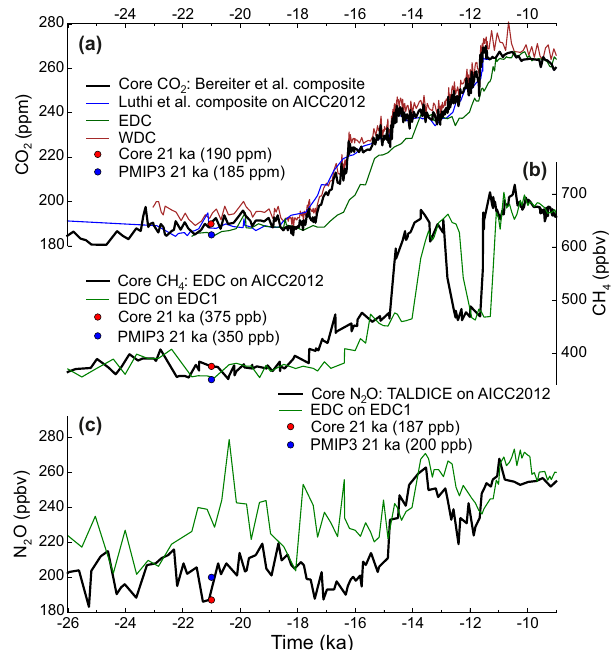
Figure 3. Atmospheric trace gases through the last deglaciation from Antarctic ice cores. (a) Core experiment carbon dioxide ac- cording to a recent composite record from EPICA Dome C (EDC), West Antarctic Ice Sheet Divide (WDC), Vostok, Taylor Dome and Siple Dome (thick black line; Bereiter et al., 2015), which was produced on the AICC2012 chronology (Veres et al., 2013). Also shown for comparison is an older composite record from EDC, Vos- tok and Taylor Dome (thin blue line; Lüthi et al., 2008, adjusted to the AICC2012 chronology), as well as the original EDC CO 2 record (green line; Monnin et al., 2004) and the recent, higher- resolution WDC CO 2 record (dark red line; Marcott et al., 2014); which were incorporated into the newer composite by Bereiter et al. (2015). (b) Methane according to the EPICA Dome C (EDC) record (Loulergue et al., 2008), shown both on the original EDC1 chronology (green line; Spahni et al., 2005) and adjusted to the more recent AICC2012 chronology for the Core experiment (thick black line; Veres et al., 2013). (c) Nitrous oxide according to the Talos Dome (TALDICE) record (Schilt et al., 2010), adjusted to the AICC2012 chronology for the Core experiment (thick black line; Veres et al., 2013). For comparison, the earlier EPICA Dome C (EDC) record on the EDC1 chronology is also shown (green line; Spahni et al., 2005). The nearest measured N 2 O concentration to 21ka is from 21.089ka; hence, there is a small offset between the slightly earlier concentration (187ppb) used for the Core and the in- terpolated value plotted at 21ka. For panels (a–c) 21ka concentra- tions according to the AICC2012 age model (red dots) are shown in contrast to previous PMIP3 LGM concentrations (blue dots; PMIP LGM Working Group, 2010). If using an equilibrium-type spin-up for the start of a transient Core simulation at 21ka (Sect. 2.1.1), use 190ppm CO 2 , 375ppb CH 4 and 200ppb N 2